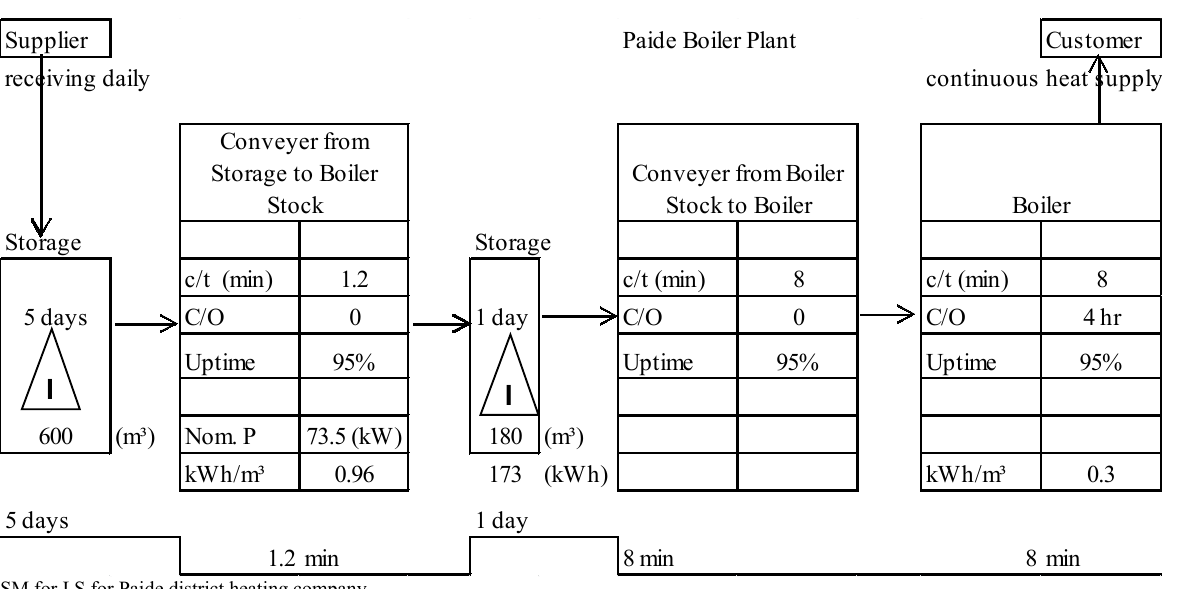
Fig. 3 VSM for LS for Paide district heating